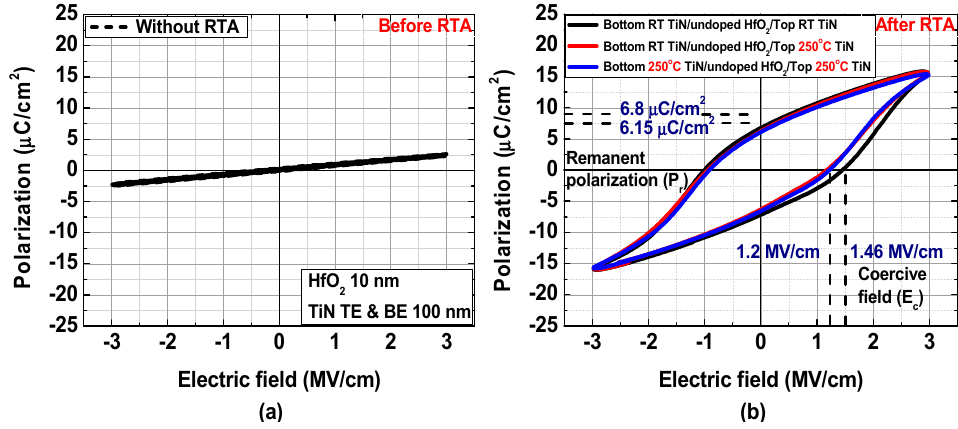
Figure 2. Polarization–electric field (P–E) characteristics of TiN/undoped HfO 2 /TiN MFM capacitors before ( a ) and after ( b ) RTA with different TiN deposition temperature conditions.